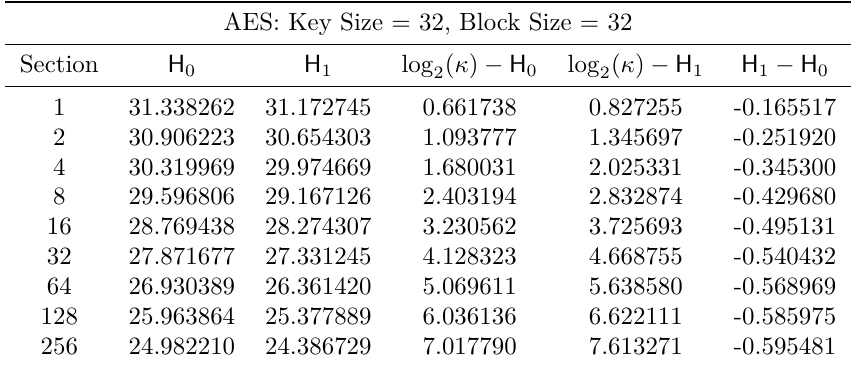
Table 1: H 0 and H 1 -entropy for 32-bit truncated AES-128 (key size is 32